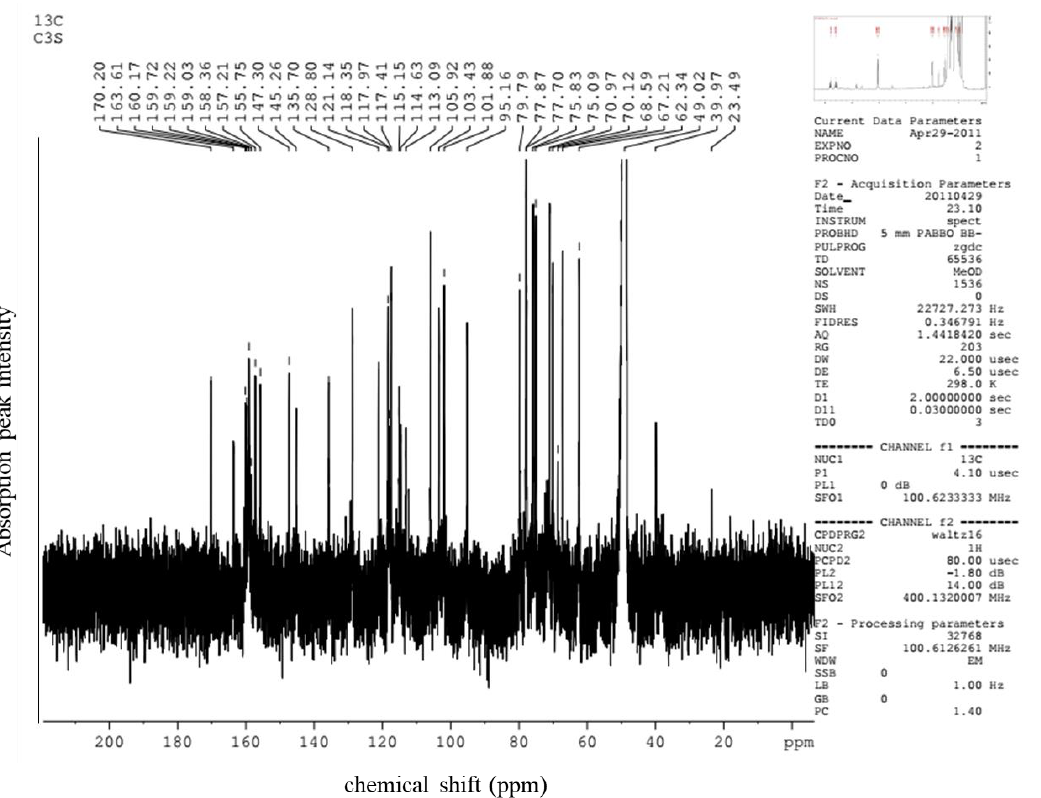
Figure A2. 13 C spectral data (ppm) for the HSCCC-purified cyanidin 3-xylosyl-galactoside.